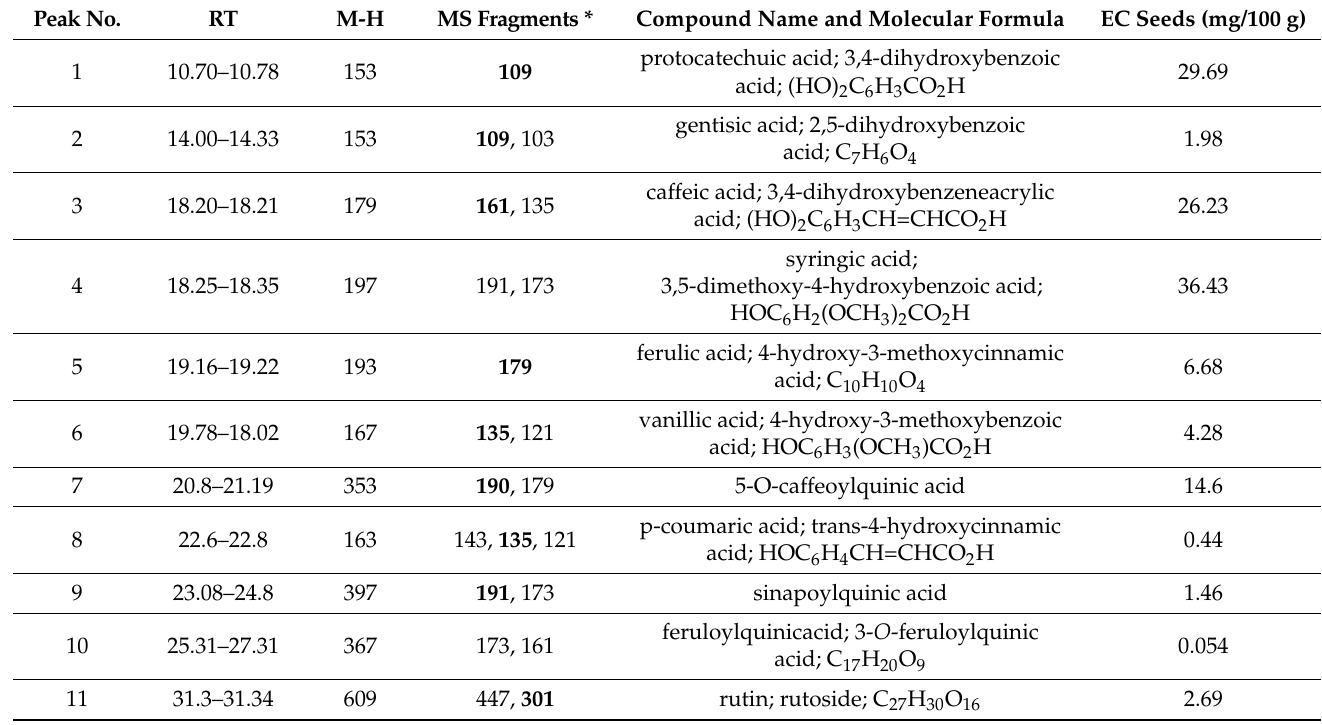
Table 1. Identification of phenolic compounds from a methanolic extract of cardamom seeds by LC-MS analysis (peaks from Figure 1A).